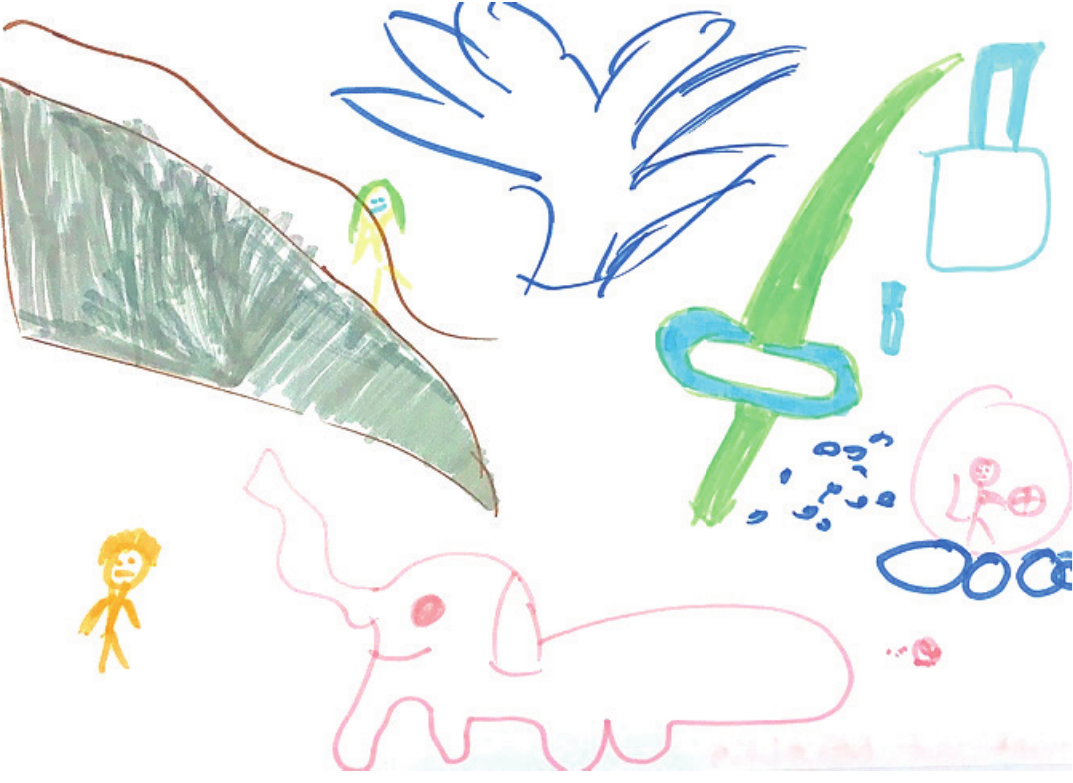
Figure 2. Sample Sketchnote drawn by a participant in a survey on the Explorer